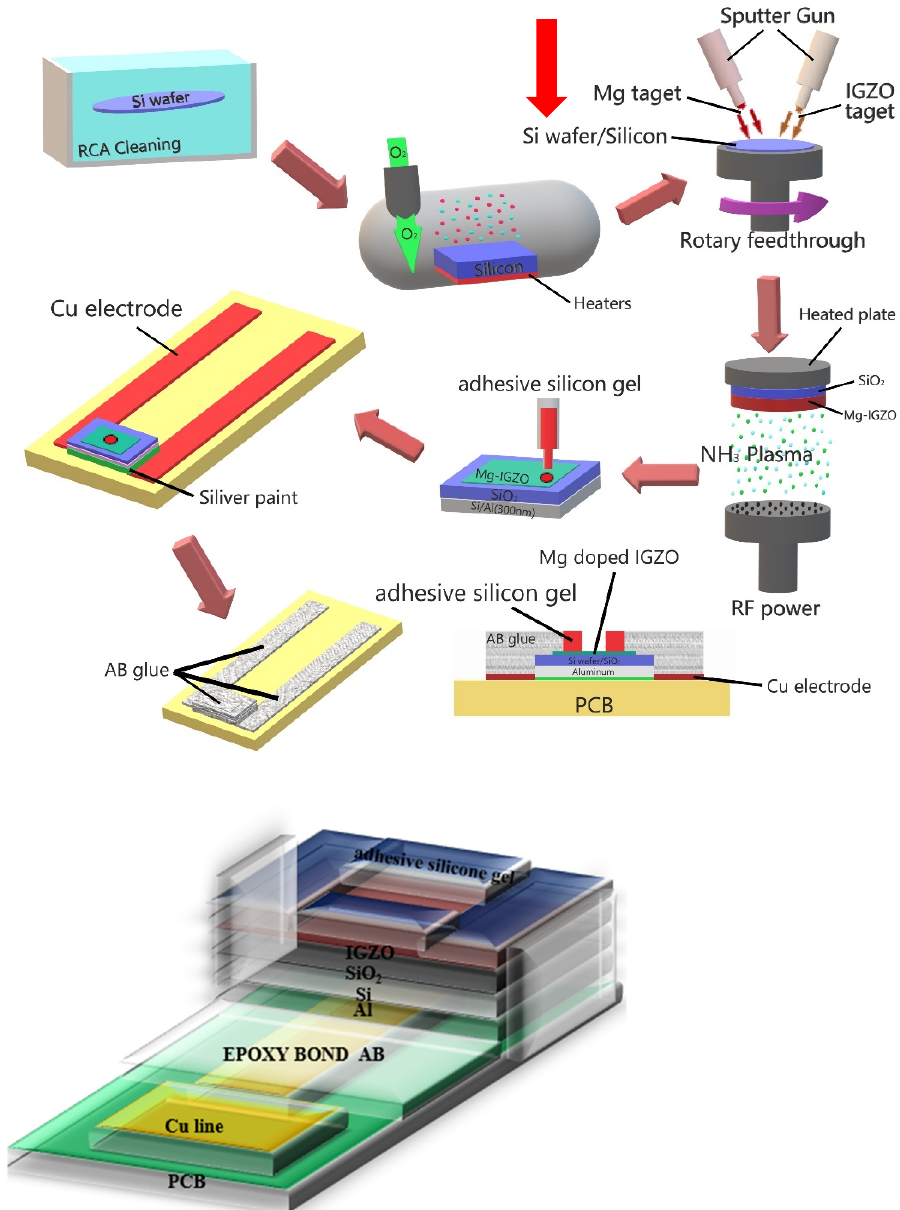
Figure 1. Schematic diagram of fabrication processes of Mg doped IGZO membranes with NH 3 plasma treatment in EIS structures.